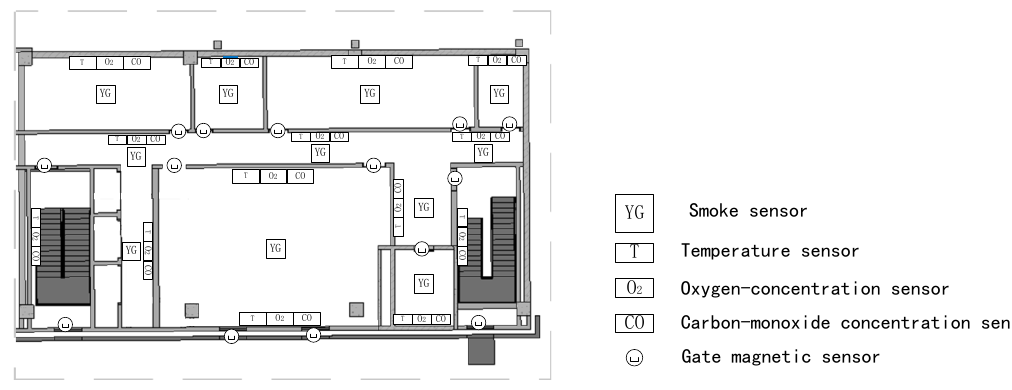
Figure 13. Layout of the indoor terminals.